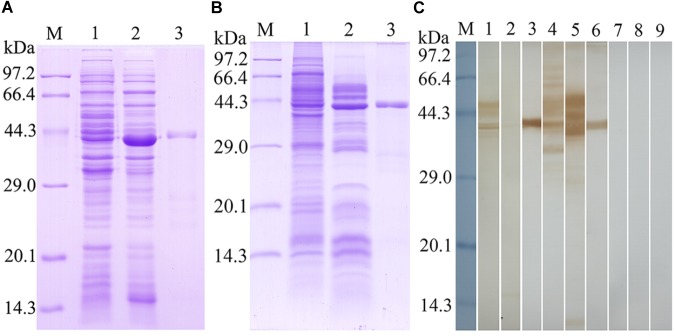
Identification of rTsSPI. (A) SDS–PAGE analysis of the rTsSPI. Lane M: molecular weight markers; Lane 1: recombinant bacteria lysate before induction; Lane 2: recombinant bacteria lysate after IPTG induction; Lane 3: the purified rTSPI. (B) SDS–PAGE of somatic proteins (Lane 1), ES proteins (Lane 2), and rTspGST (Lane 3). (C) Western blotting. The native TsSPI protein in ML somatic proteins (lane 1) and ES proteins (lane 2) as well as the rTsSPI (lane 3) were identified by anti-rTsSPI serum. The ML somatic proteins (lane 4), ES proteins (lane 5) and rTsSPI (lane 6) were also probed with serum samples of T. spiralis-infected mice. The ML somatic proteins (lane 7), ES proteins (lane 8), and rTsSPI (lane 9) were not recognized with pre-immune sera of normal mice.